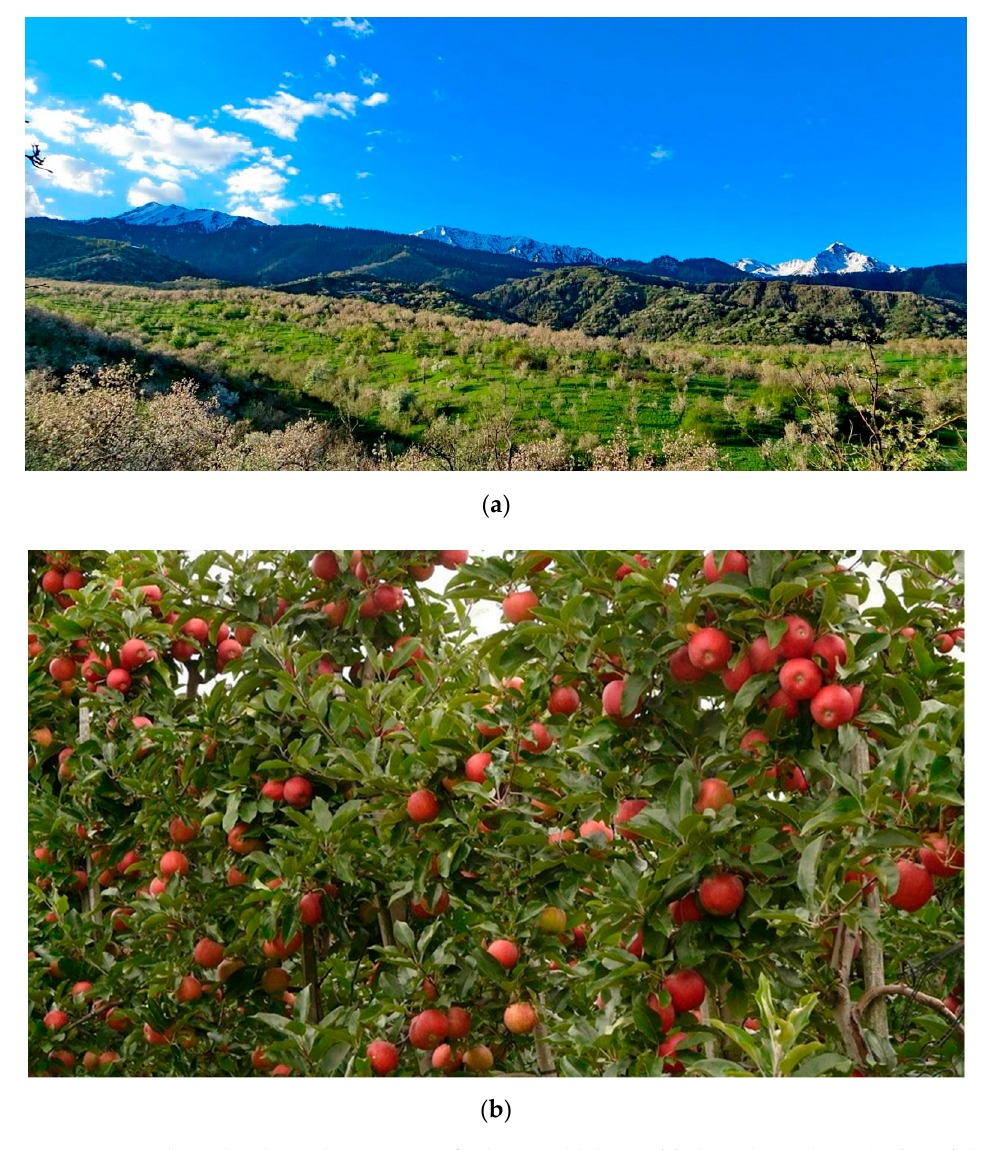
Figure 1. Apple orchards in the vicinity of Almaty. ( a ) https://adrenalinicsilence.kz/portfolio- archive/yablonevye-sady (accessed on 6 June 2022). ( b ) https://www.nur.kz/society/1879643- gektary-ablonevyh-sadov-vyrubili-v-almatinskoj-oblasti-video/ (accessed on 8 July